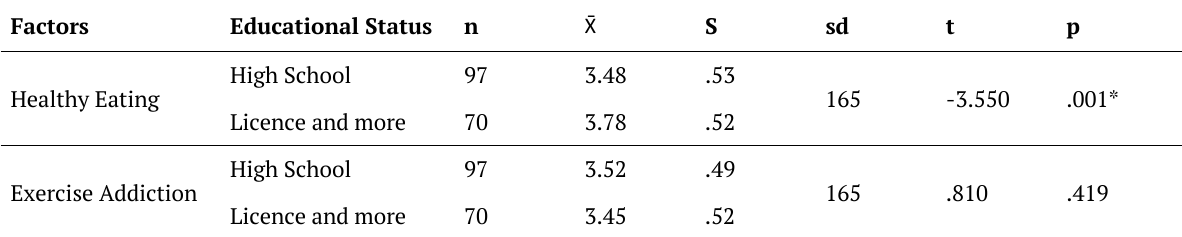
Table 2. T-test results of female football players’ attitude to healthy eating and exercise addiction by training status